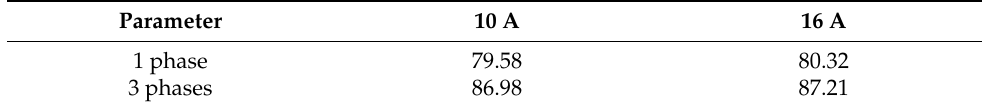
Table 8. Charging efficiency in% of the Kia